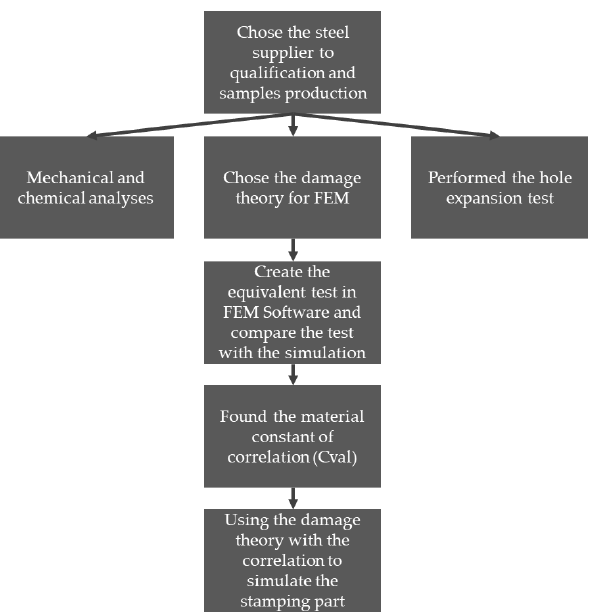
Figure 13. Methodology: schematic steps to predict premature cracking (source: author).